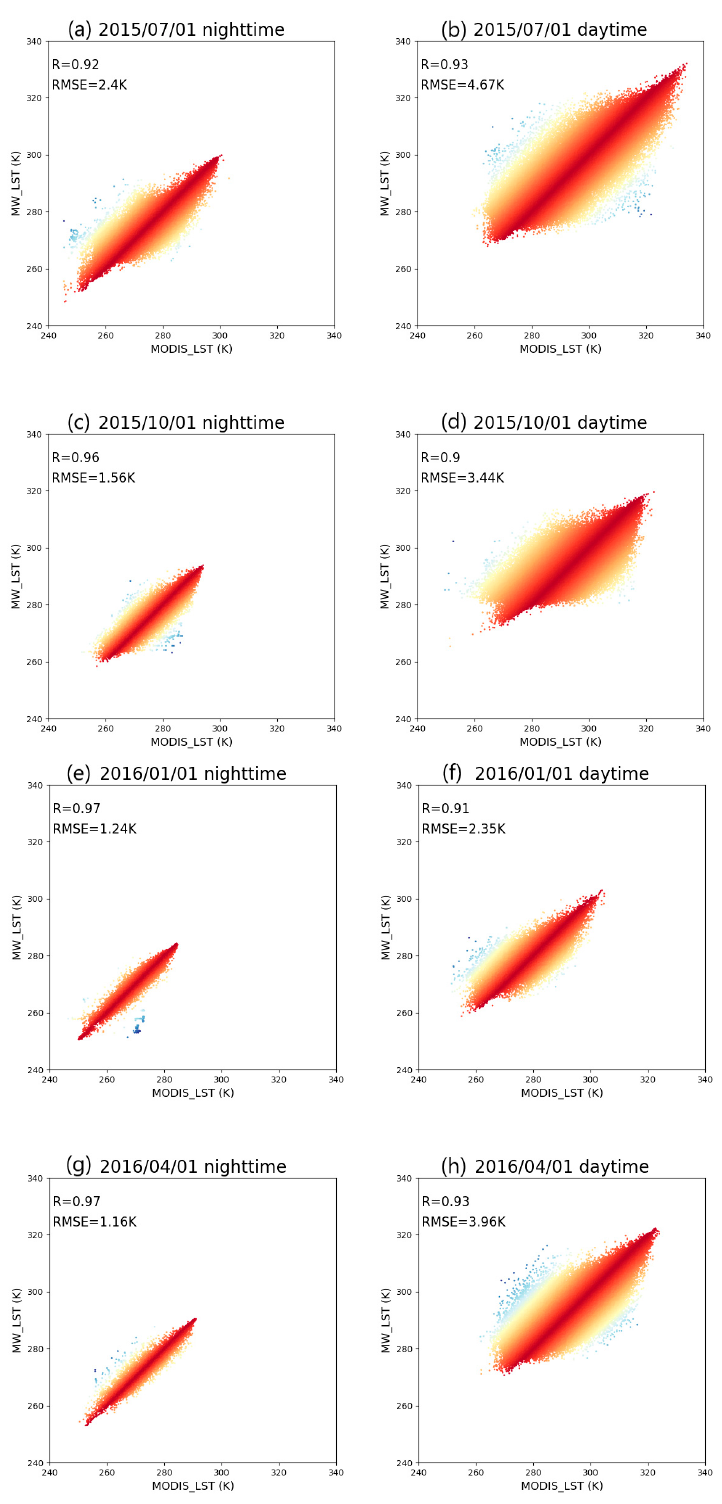
Figure 11. Scatterplot of predicted LST and MODIS LST ( a ) 2015/07/01 night. ( b ) 2015/07/01 day. ( c ) 2015/10/01 night. ( d ) 2015/10/01 day. ( e ) 2016/01/01 night. ( f ) 2016/01/01 day. ( g ) 2016/04/01 night. ( h ) 2016/04/01 day. The darker color indicates a stronger correlation between two variables.